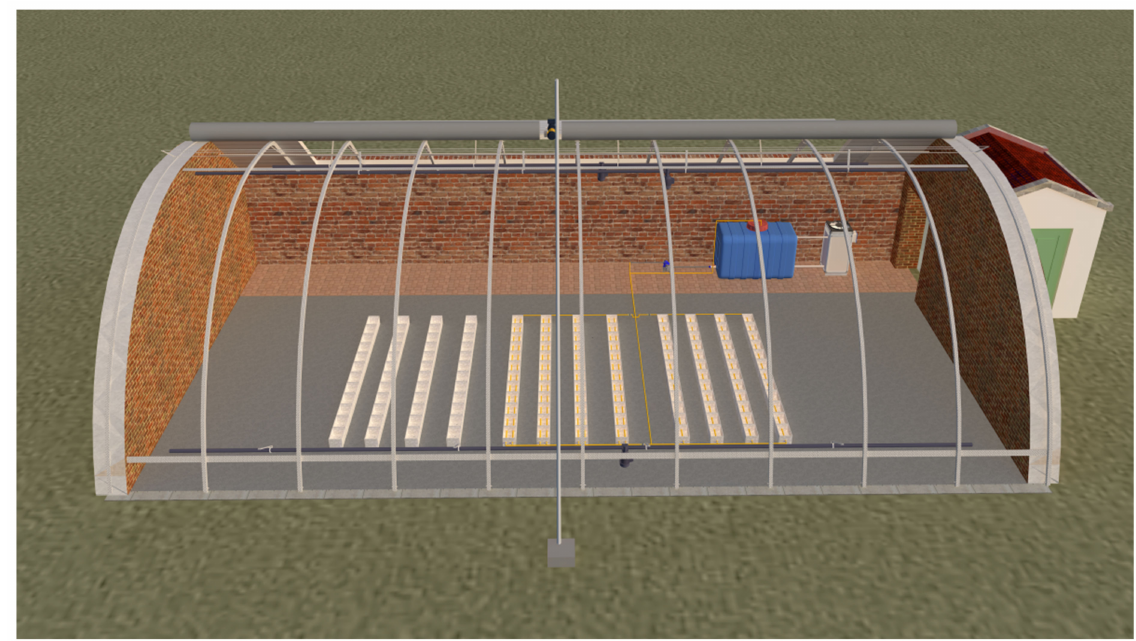
Figure 2. Diagrammatic drawing of experimental